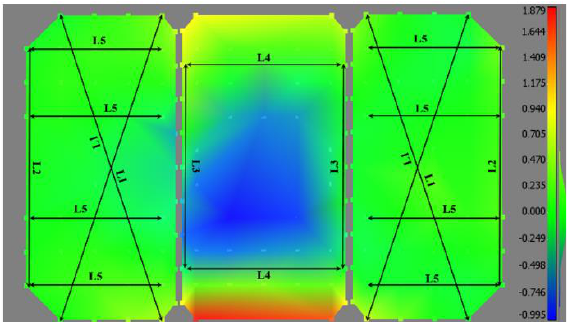
Figure 6. Reference distances used for the accuracy evaluation. Nominal values for the reference distances are L1=950mm, L2=700, L3=600, L4=480, L5=400. The three panels of the test object are coloured according to their deformation from planar surfaces fitting the 3D points.